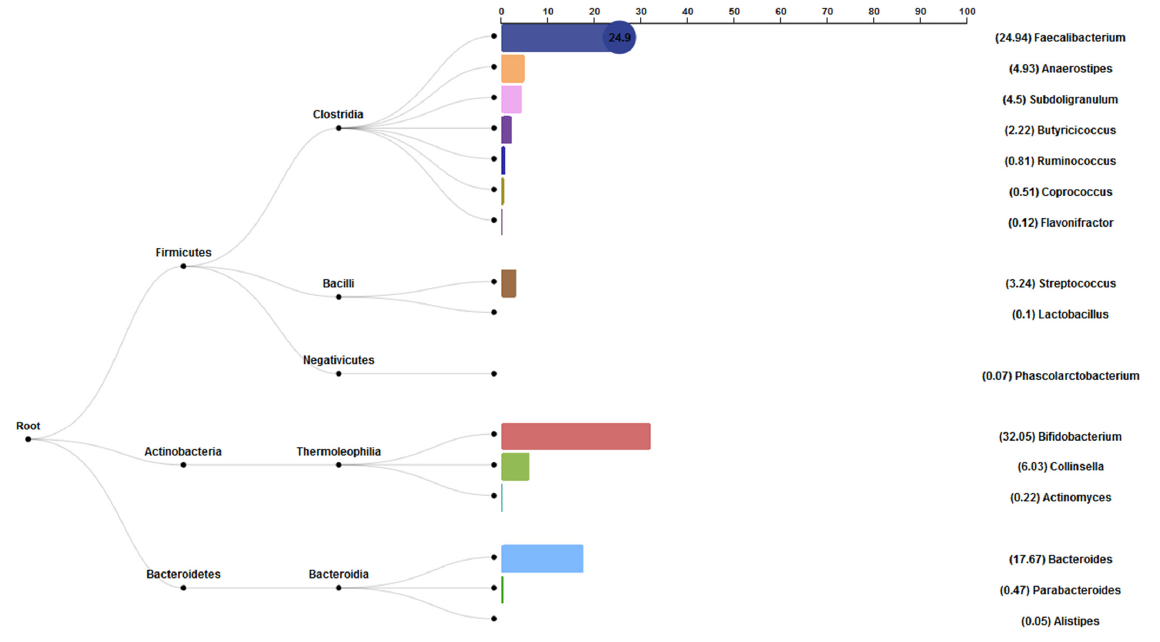
Figure 7. Bacterial abundance in the resistant group.